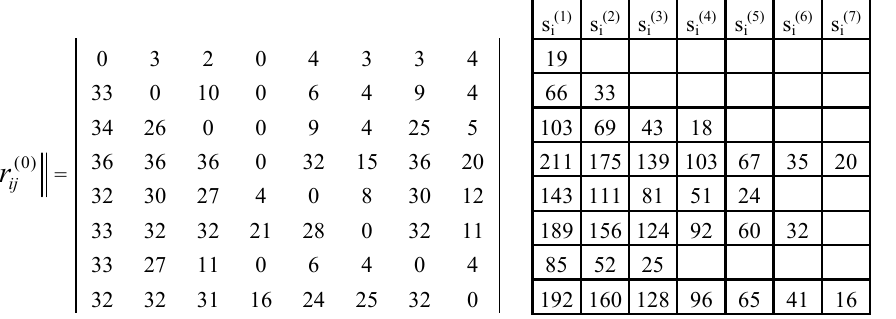
Table 6 – Application of the heuristic algorithm for calculating the Kemeni median